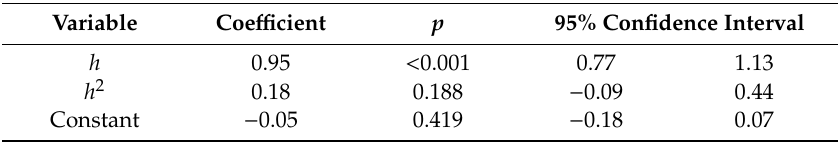
Table 12. Link test (third